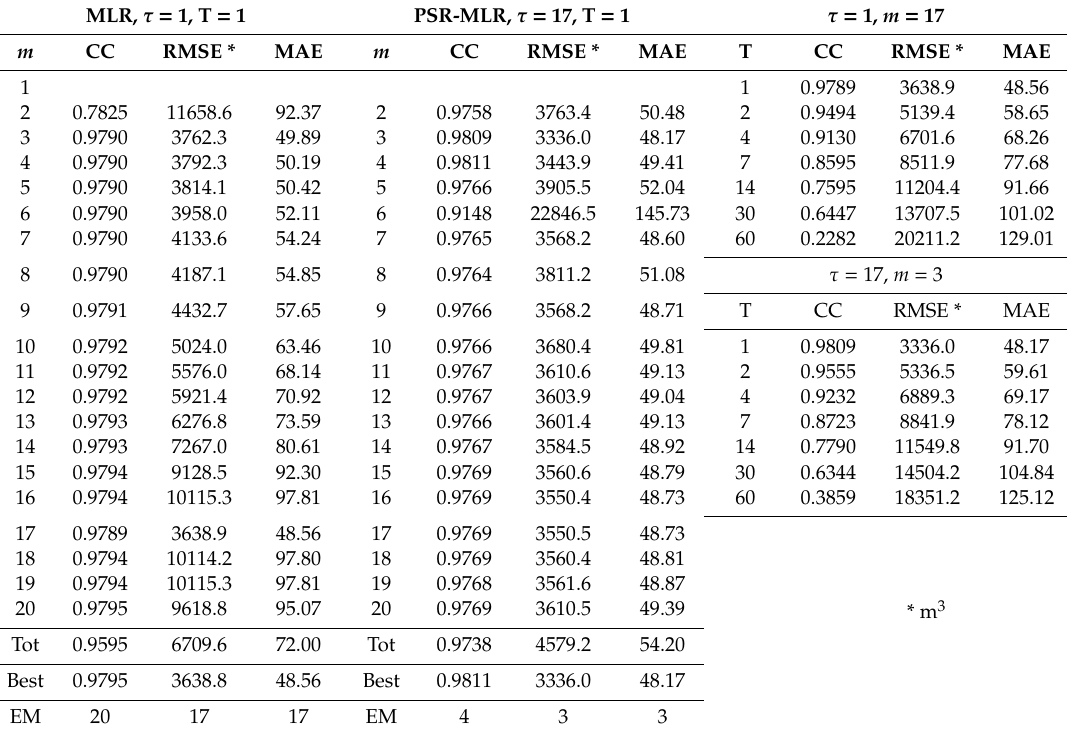
Table 5. Fitness values for MLR and PSR-MLR methods in di ff erent embedding dimension lag time and lead